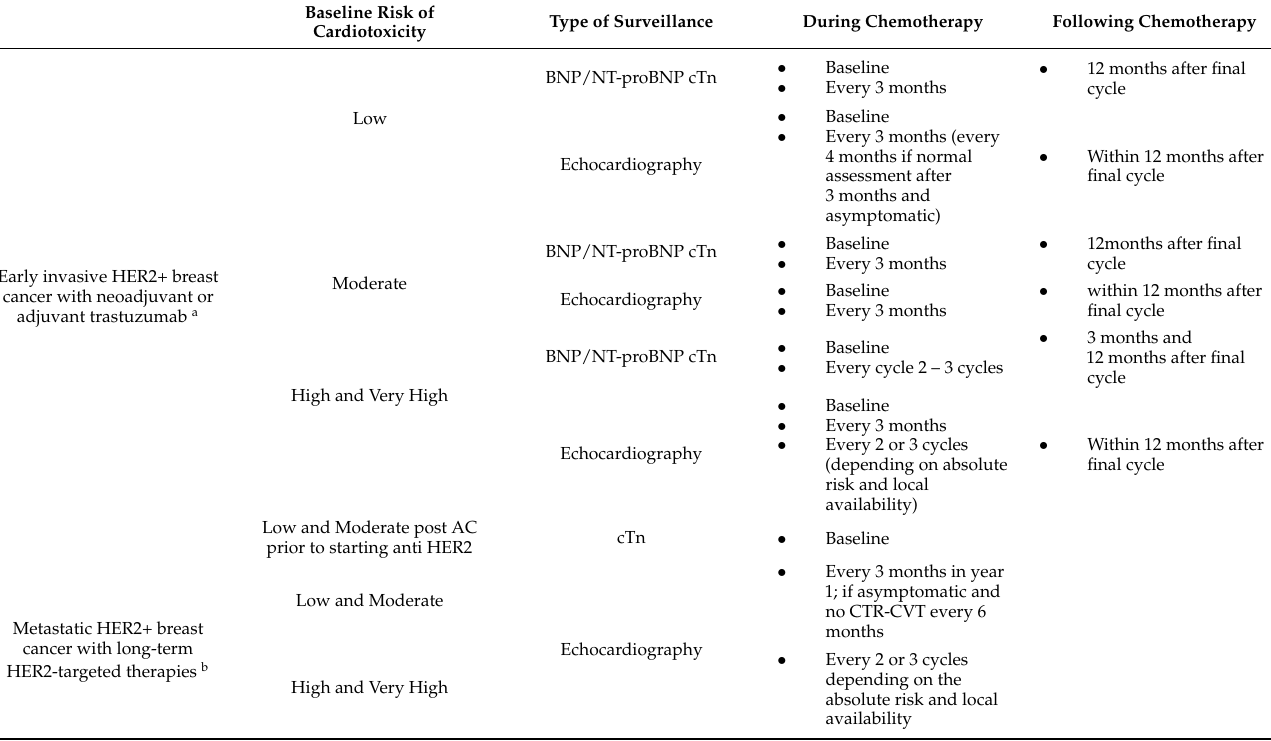
Table 3. Biomarker and echocardiographic surveillance during and after HER2-targeted